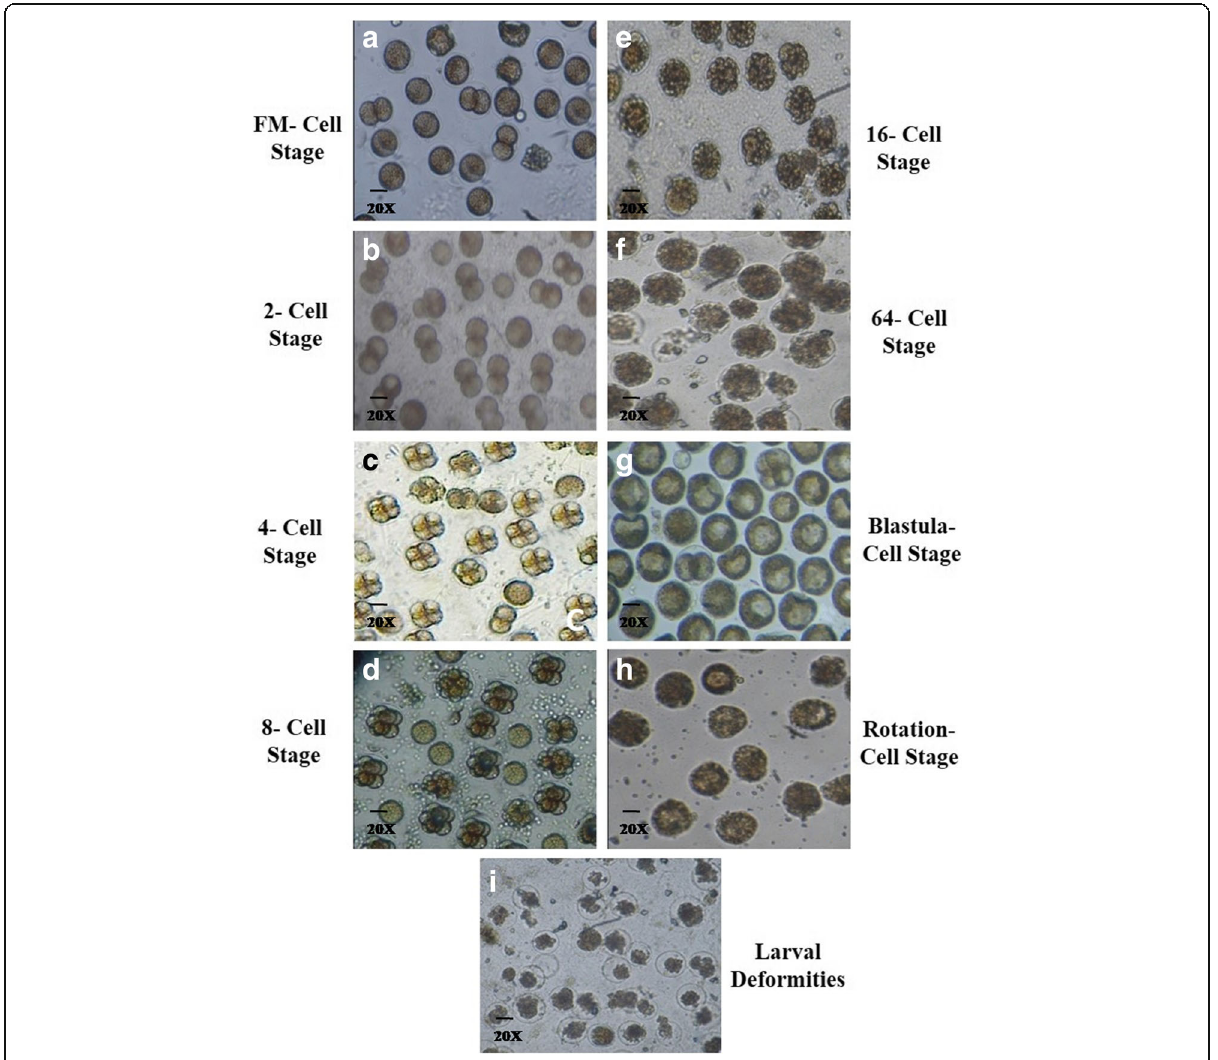
Fig. 5 a – i Effect of silver nanoparticles (EC 50 — 3 nM) on fertilization and early developmental stages of Hydroides